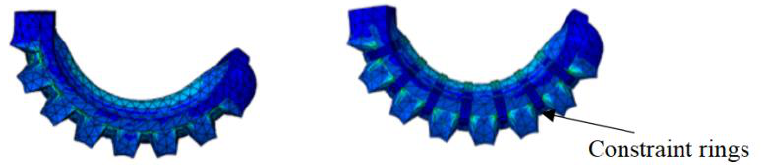
Figure 7. Comparison diagram of finite element simulation with and without constraint rings.